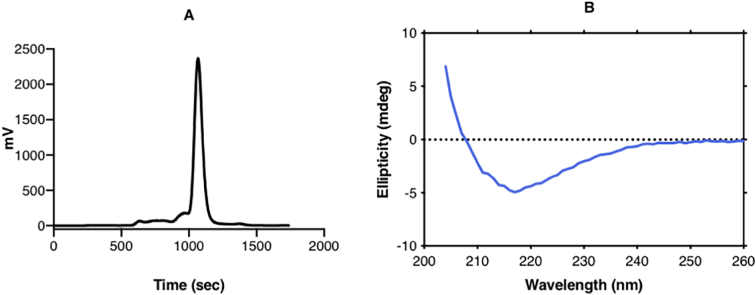
Preparation and characterization of FcμR Ig binding domain (sIgFcμR).sIgFcμR protein was purified by SEC (panel A) and analyzed using far-UV CD spectroscopy at 0.1 mg/mL (panel B).